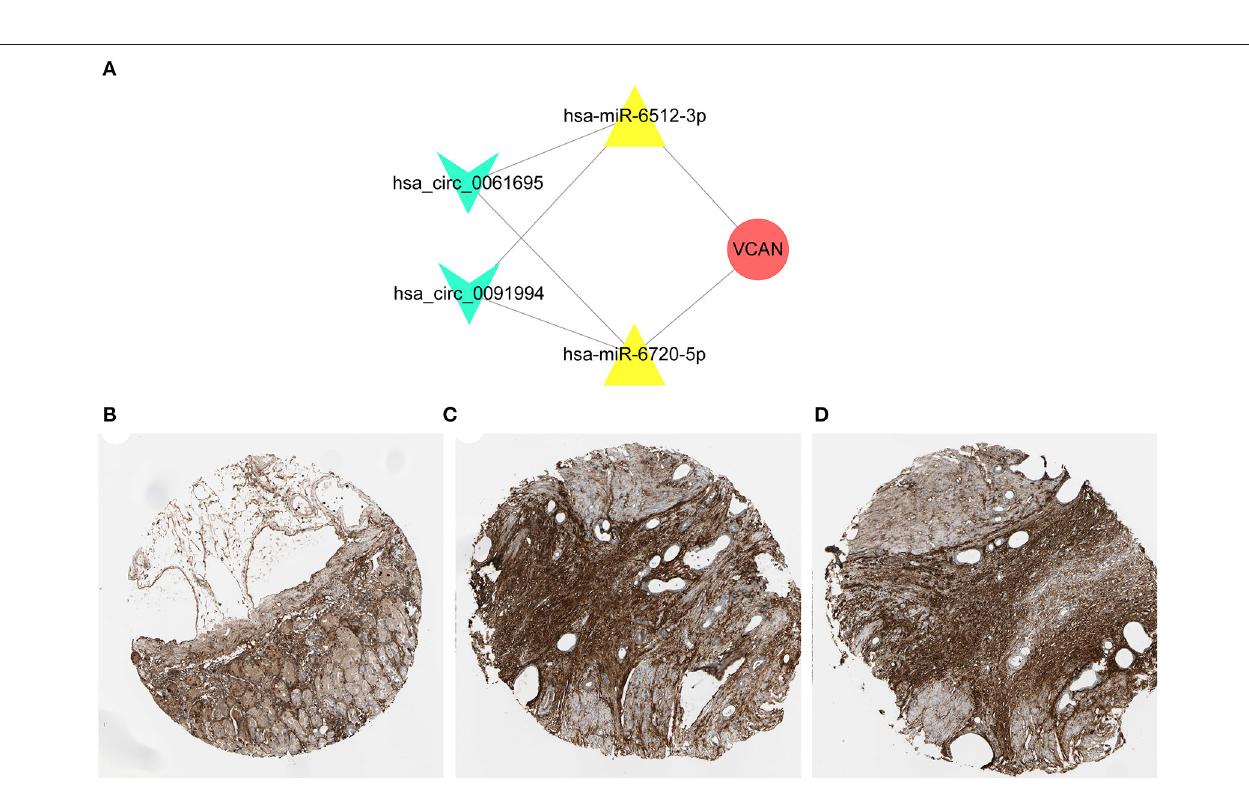
Frontiers in Medicine |